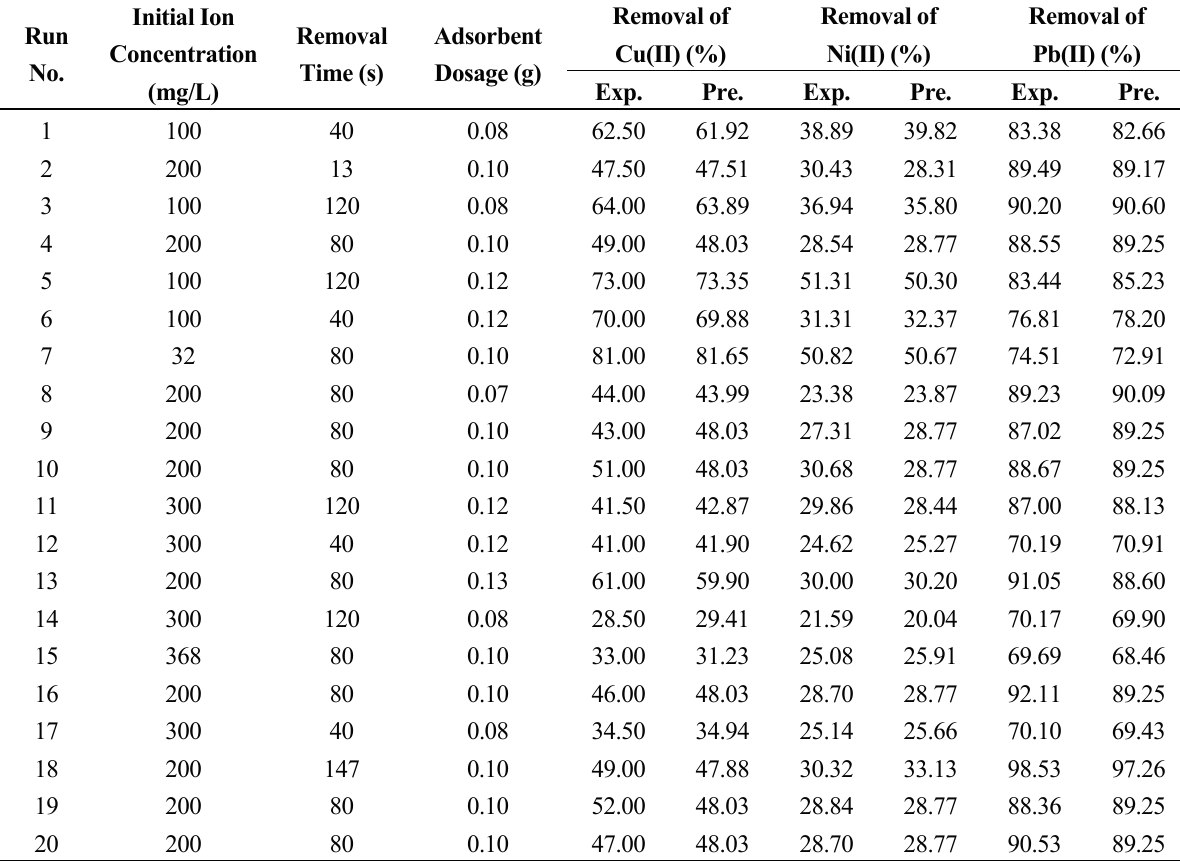
Table 1. Predicted (Pre.) and experimental (Exp.) design matrix obtained by